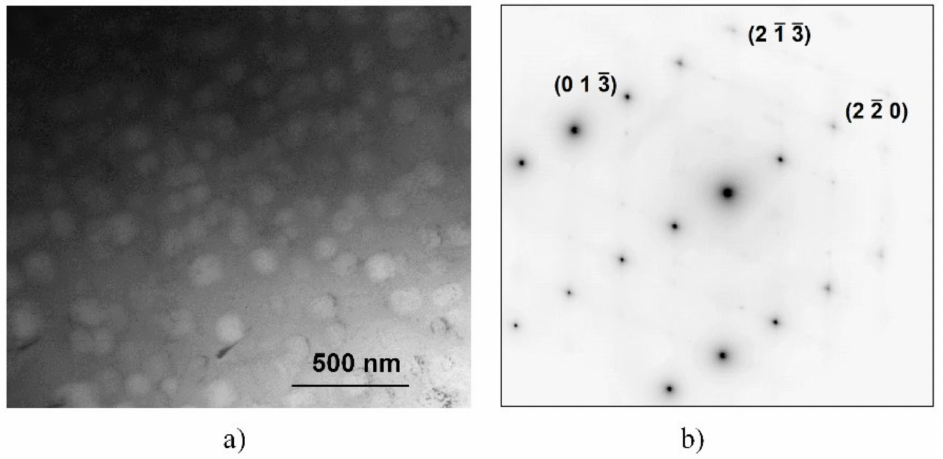
Figure 6. Microstructure of the BCC region of the SC sample heat-treated at 1150 K for 1 h and slowly cooled, shown by bright-field TEM ( a ) and corresponding selected area electron diffraction (SAED)-pattern ( b ) from the zone-axis of orientation